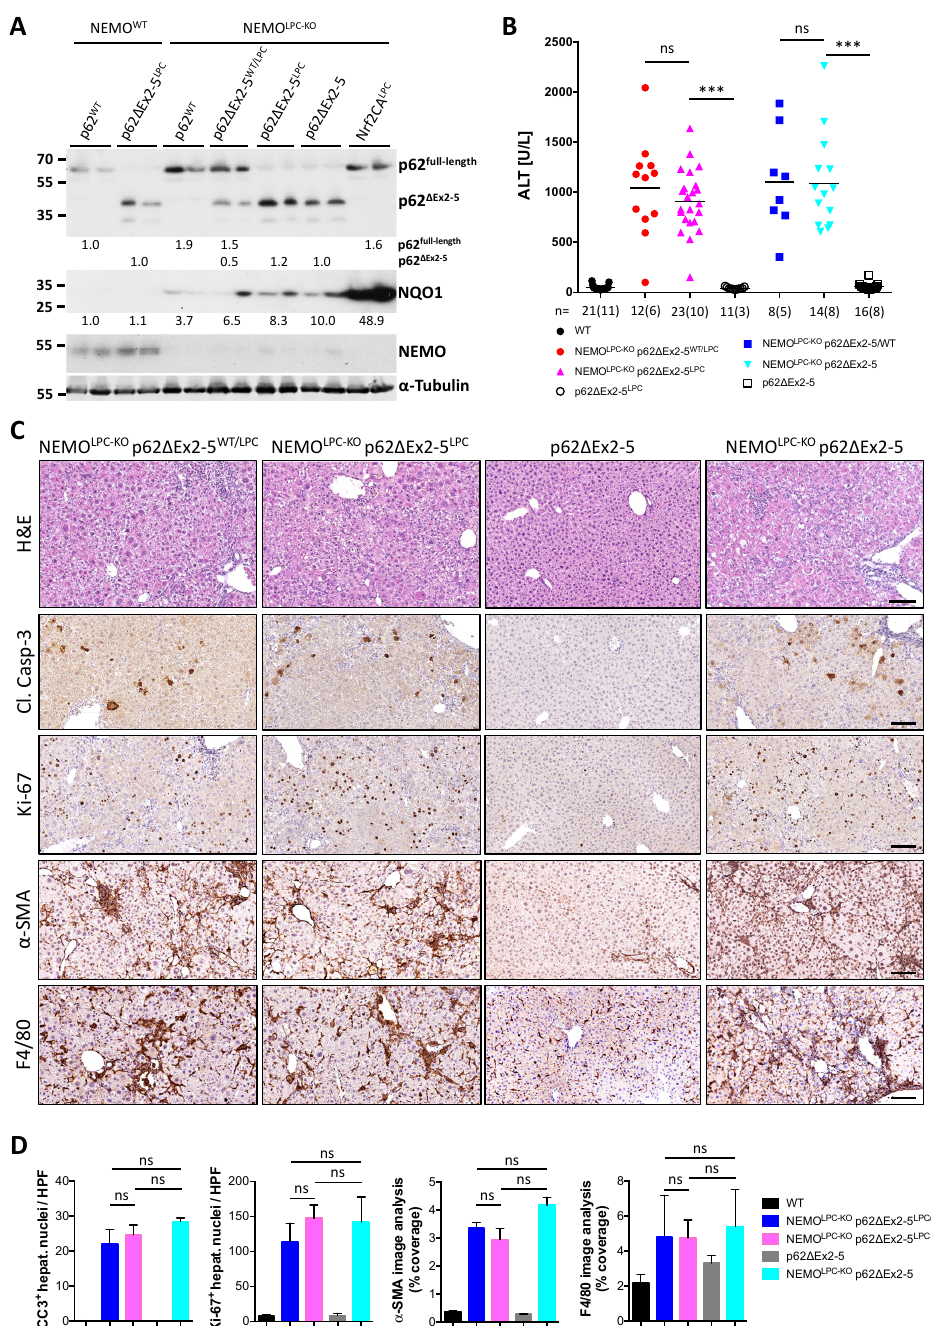
Figure 4. Expression of the p62 ∆ Ex2-5 mutant does not prevent the liver pathology in NEMO LPC-KO mice. ( A ) Immunoblot analysis of p62, NQO1 and NEMO in total liver lysates from 8-week-old mice with the indicated genotypes. α -Tubulin is used as the loading control. Band quantification represents the mean intensity per genotype relative to control mice and normalized to α -tubulin. Uncropped scans of the immunoblots are shown in Figure S5. ( B ) Serum ALT levels in 8-week-old mice with the indicated genotypes. Each symbol represents one mouse and horizontal lines indicate mean values. n indicates the number of analyzed mice, out of which the number of males is shown in brackets. ( C ) Representative images of liver sections from 8-week-old mice with the indicated genotypes after immunostaining with the indicated antibodies. ( D ) Quantification of the depicted markers in ( C ). Graphs show mean ± SEM ( n = 3–8 mice per genotype). Each dot represents the average value per analyzed mouse with the indicated genotype. ns, not significant; *** p ≤ 0.005. Bars: 200 µ